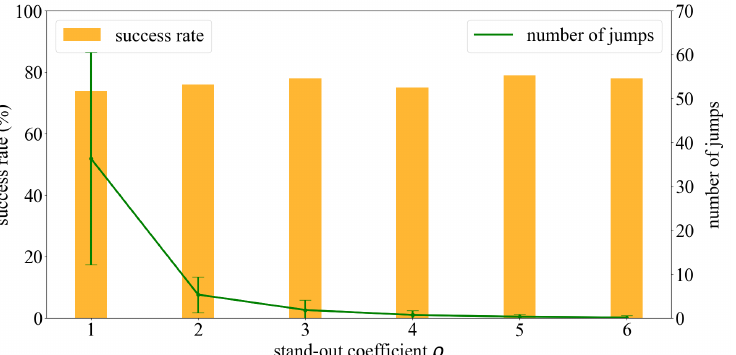
Figure 13. With the same K = 8, different stand-out coefficients result in a similar success rate but the number of jumps changes